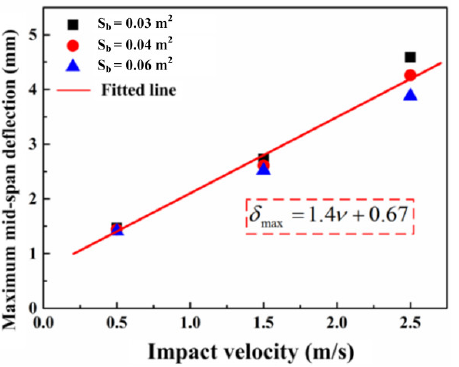
Figure 14. The relation between dynamic response and impact velocity. to the deformation resistance for the increases in the reinforced concrete beam.